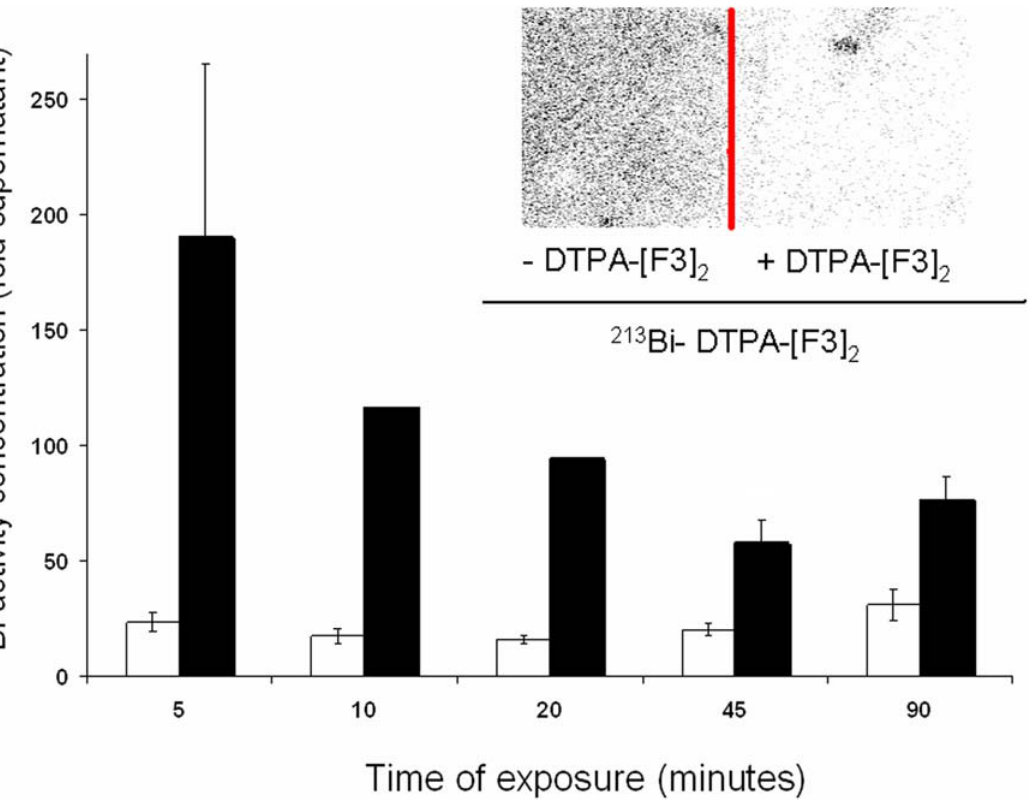
Figure 1. Internalization of 213 Bi-DTPA-[F3] 2 into MDA-MB-435 tumor cells. The radioactivity concentration present in the cytoplasm and the nuclei of cells incubated with 3.7 kBq/ml 213 Bi-DTPA-[F3] 2 for the indicated time periods was measured and compared to the radioactivity concentration in the supernatant. The bars represent the radioactivity in the nuclei (black, p , 0.01, *=p , 0.02) or the cytoplasm (white, p , 0.01) compared to the supernatant. Values 6 SEM are shown. The inset shows binding of 213 Bi-DTPA-[F3] 2 to tumor cells grown on glass cover slips in presence or absence of unlabelled DTPA-[F3] 2 , visualized by a micro imager.